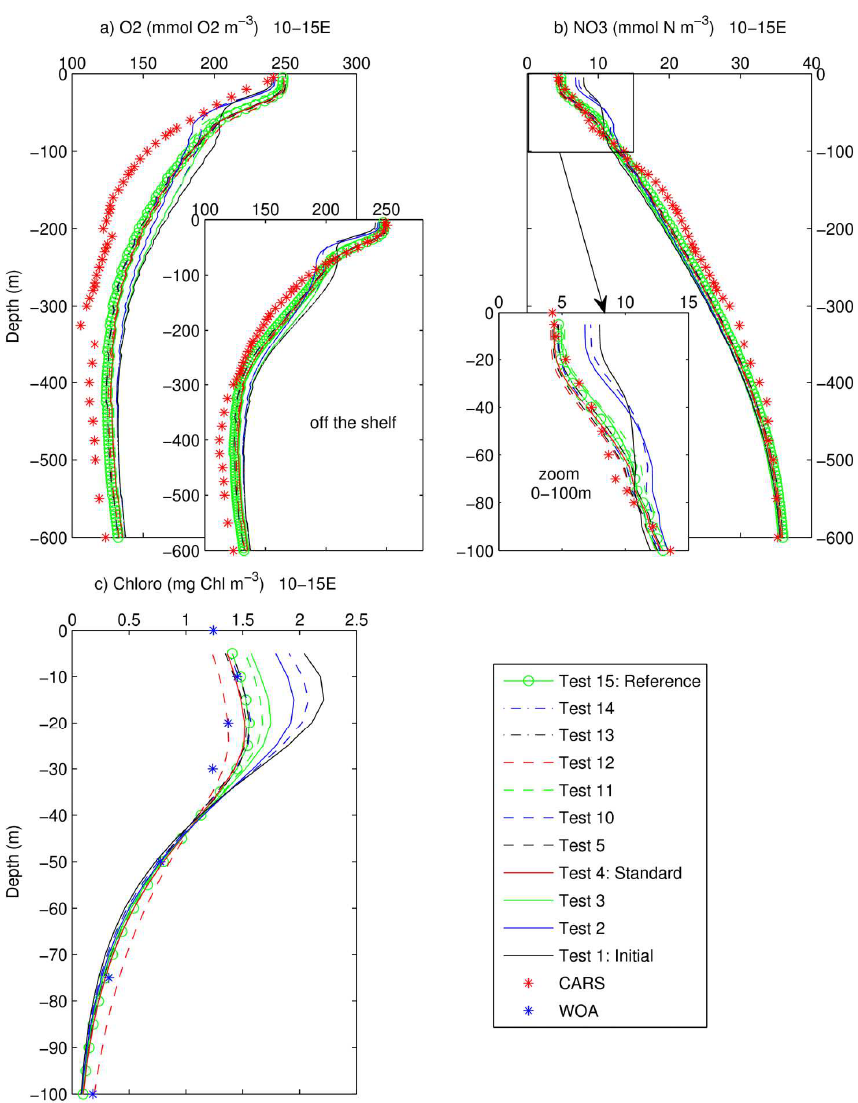
Fig. 10. Eight-year averaged vertical profiles for O 2 (a) and NO − (b) concentrations from the surface to 600m depth, and for chlorophyll a 3 concentrations (c) from the surface to 100m depth, for different tests. Vertical profiles were averaged between 22–24 ◦ S and 10–15 ◦ E. For oxygen, vertical profiles excluding the continental shelf overlap in (a)